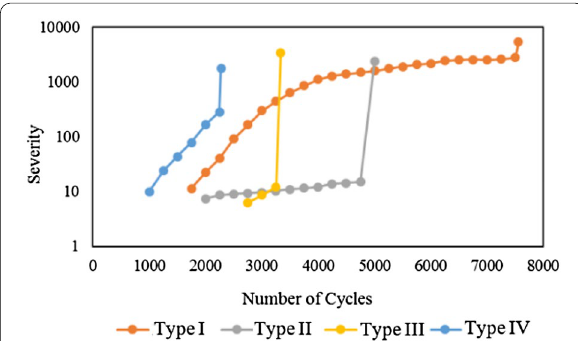
Fig. 10 Variation of the severity against the number of cycles for all types of